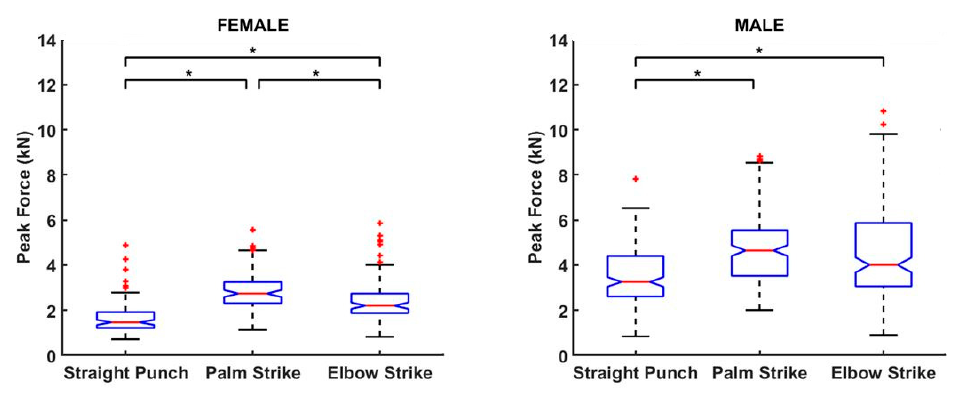
Figure 3. Peak force comparison of male and female strike techniques. * significantly different at p < 0.01.